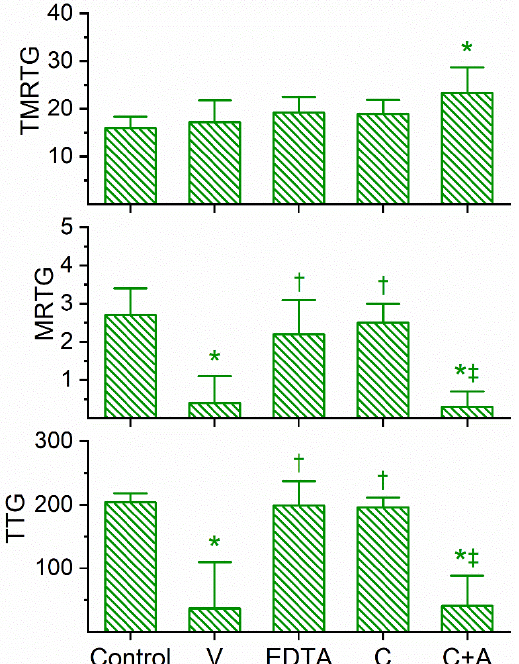
Figure 3. Anticoagulant activity of D. jamesoni venom in human plasma and effects of EDTA and Figure3. Anticoagulantactivityof D.jamesoni venominhumanplasmaande ff ectsofEDTAandCORM-2 CORM-2 on venom activity. Data are presented as mean ± SD. TMRTG = minutes; MRTG = on venom activity. Data are presented as mean ± SD. TMRTG = minutes; MRTG = dynes / cm 2 / sec; dynes/cm 2 /sec; TTG = dynes/cm 2 . Control = No additives; V = 1 µg/mL final venom concentration; TTG = dynes / cm 2 . Control = No additives; V = 1 µ g / mL final venom concentration; EDTA = 1 µ g / mL venom after being exposed to 5 mM EDTA; C = 1 µ g / mL venom after being exposed to 100 µ M CORM-2 EDTA = 1 µg/mL venom after being exposed to 5 mM EDTA; C = 1 µg/mL venom after being exposed in PBS; C + A = 1 µ g / mL venom after being exposed to 100 µ M CORM-2 in 5% human albumin. * p < 0.05 to 100 µM CORM-2 in PBS; C+A = 1 µg/mL venom after being exposed to 100 µM CORM-2 in 5% vs. control; † p < 0.05 vs. V; ‡ p < 0.05 vs. human albumin. * p < 0.05 vs. control; † p < 0.05 vs. V; ‡ p < 0.05 vs. C.